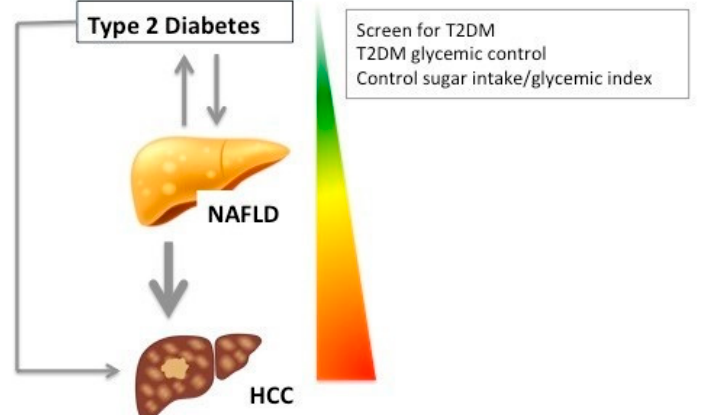
Figure 2. T2DM and NAFLD are linked through a bidirectional relationship: NAFLD increases the risk of T2DM occurrence and T2DM is a risk factor for NAFLD development and fibrosis progression. Total sugar intake and T2DM are independent risk factors for hepatocellular carcinoma (HCC).